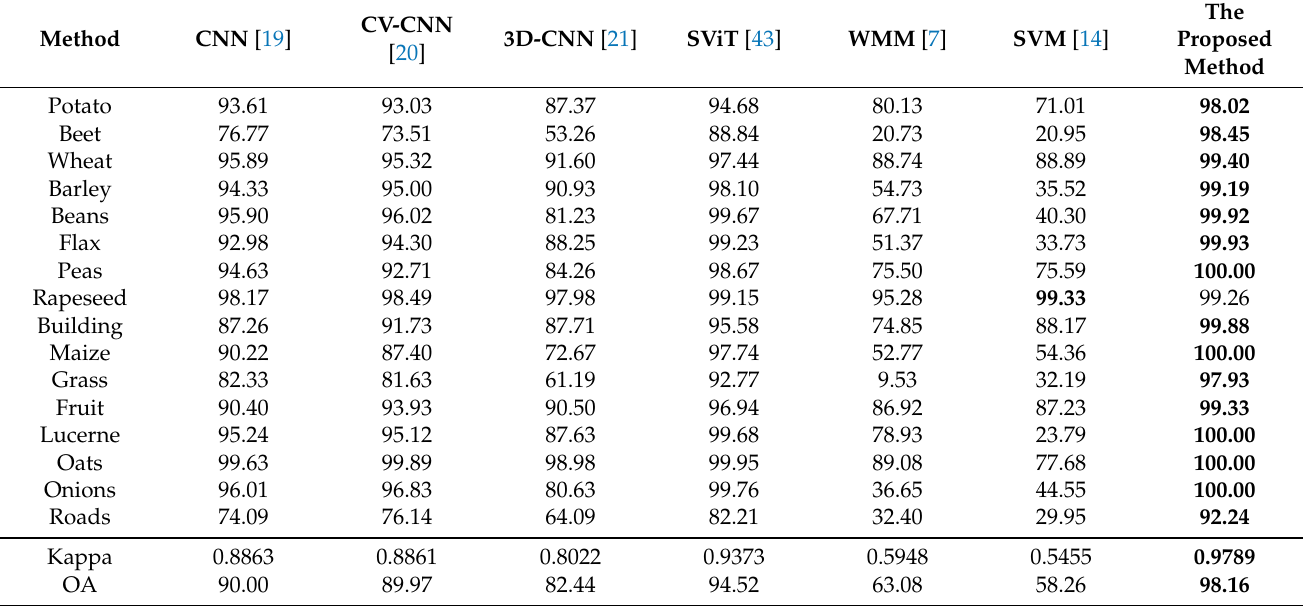
Table 2. Classification results on the P-band Flevoland